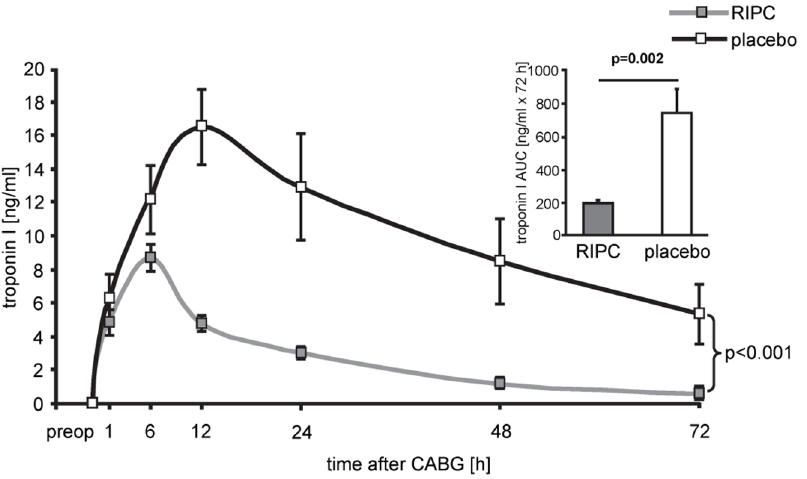
Figure 1. Serum concentration of troponin I. Serum concentration of troponin I before (preop) and over 72 hours after coronary artery bypass grafting (CABG) in patients undergoing remote ischemic preconditioning (RIPC) or not (placebo). Decreased troponin I concentrations confirmed protection by RIPC. Insert: area under the curve (AUC) for serum troponin I concentrations over 72 h.